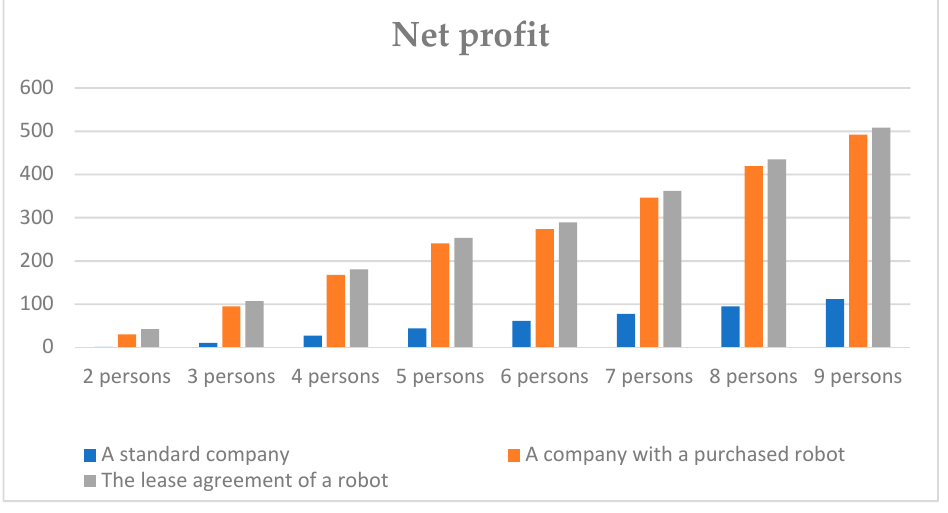
Figure 4. Profitability of the business in three varieties for businesses employing between 2 and 9 people. The taxes do not take account of the tax on robotification. A kind of a barrier preventing the micro-entities from purchasing a robot is a significant increase in debt. The indicator of indebtedness for companies employing above three people after the robotification conducted by means of purchasing a robot exceeds a safe level: foreign capital, as well as a loan, exceeds the wealth possessed by the simulated business entity (Figure 5.). The risk does not occur in the case of the option of renting a robot, with the company retaining a relatively high level of the increase in the resulting savings. However, the purchase of the robot allows for achieving better liquidity (Figure 6) because the loan for the purchase of a robot will be repaid in the form of expenses (financial gear). At the second stage of the simulation, the option of renting a robot was selected for the purpose of the increased tax levy. Figure 7 shows what the liquidity of the simulated business entity looks like. It is a business entity which decided to rent a robot compared with the business entity which retained the traditional model of providing services. Additionally, the tax burden was also presented, resulting from imposing the additional tax on robotification. As one may observe, the liquidity of the business entity which rents